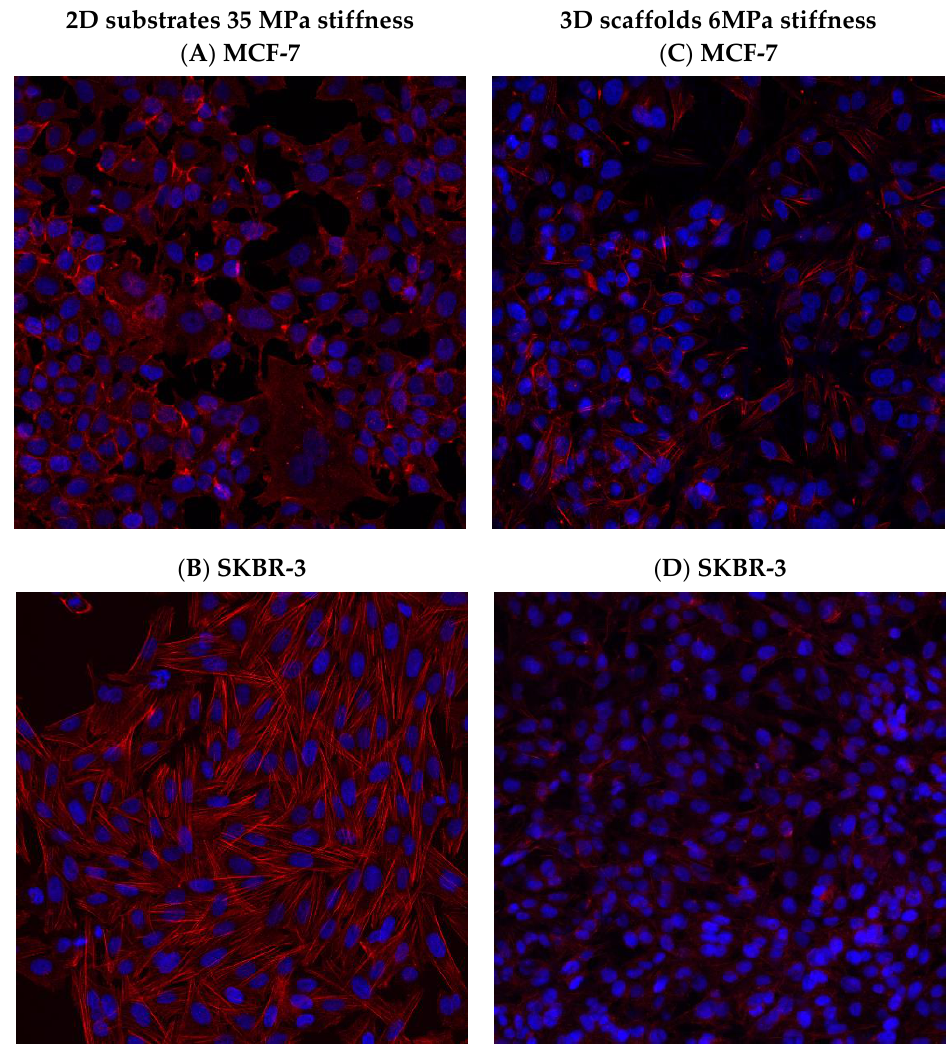
Figure 8. Representative image of F-actin morphology (red) and nuclei (blue) of MCF-7 and SKBR-3 control cells seeded upon 2D ( A , B ) and 3D scaffolds ( C , D) with different stiffness. SKBR-3 morphology was markedly altered when cells cultured upon 3D PCL scaffolds. Analytical images of 24 h and 48 h post treatment are depicted in Supplementary Figures S1–S4.